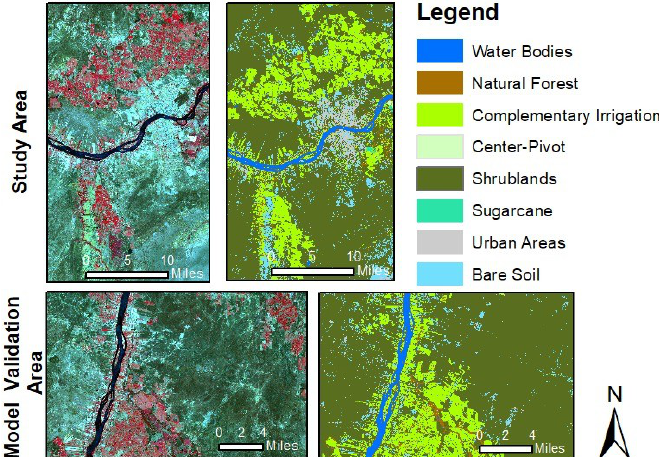
Figure 3 . False Color composition (NIR, Red, Green), and result of the classification for training area in the region of Juazeiro/Petrolina hub.